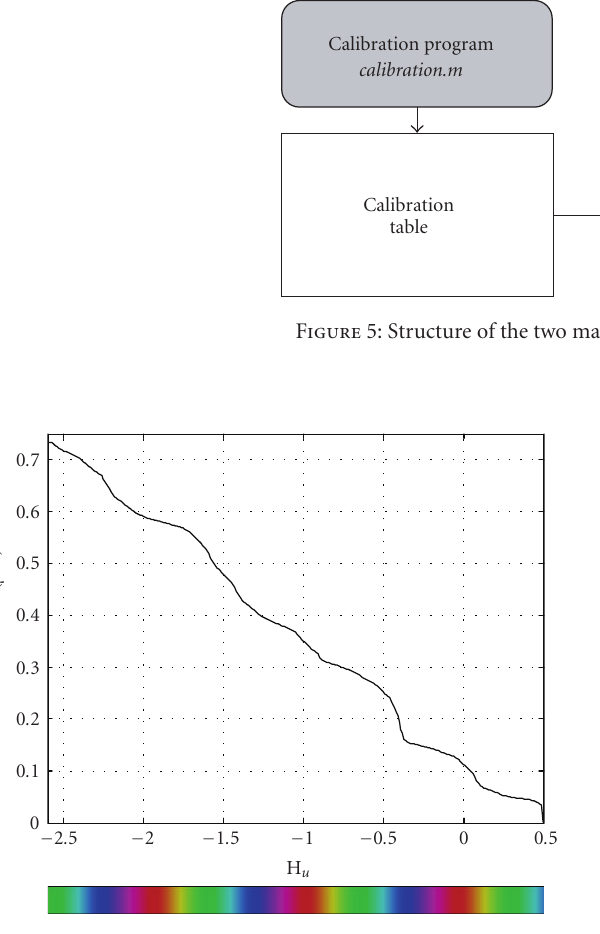
Figure 6: Calibration curve uniquely associating film thicknesses to unwrapped H values. The corresponding colours are shown in the colour bar (only hues, not considering possible variations of satu- ration and